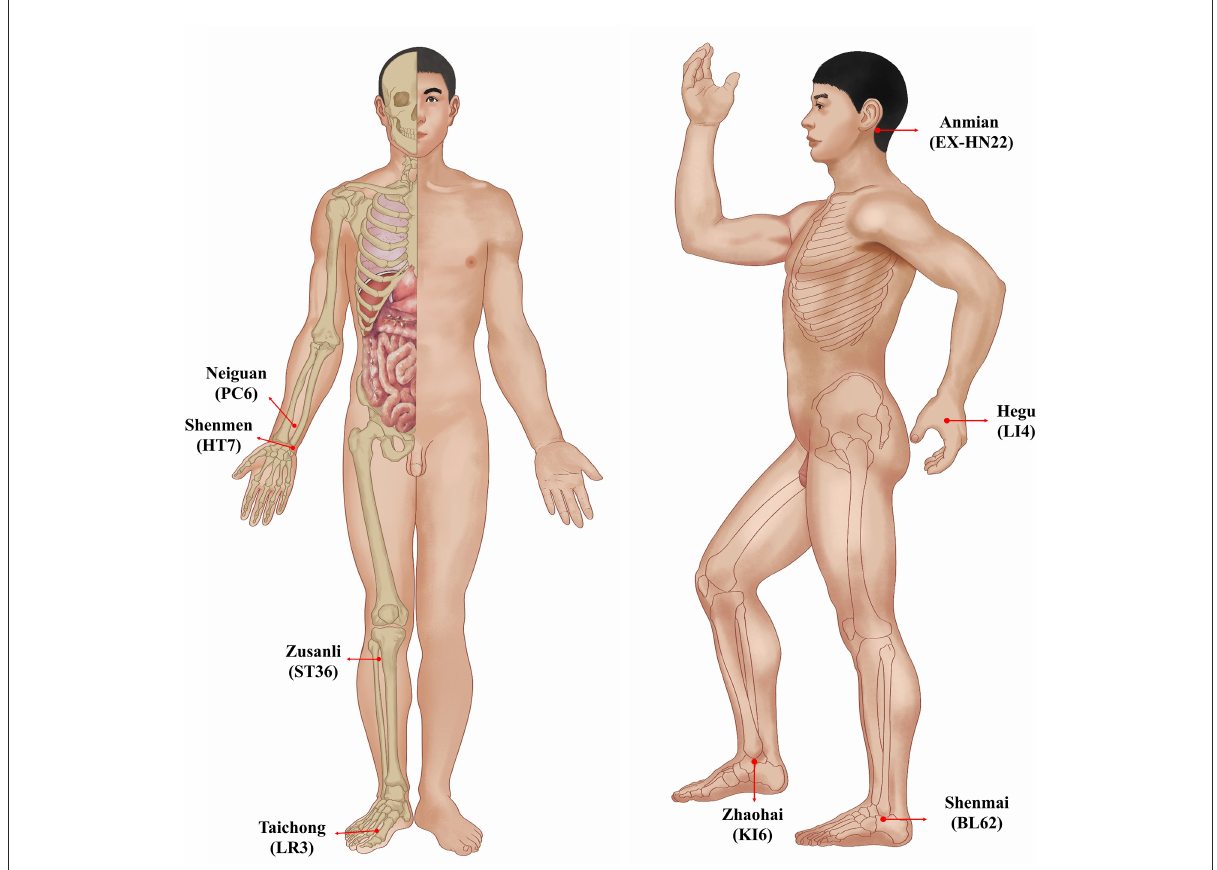
FIGURE1 Location of acupoints.